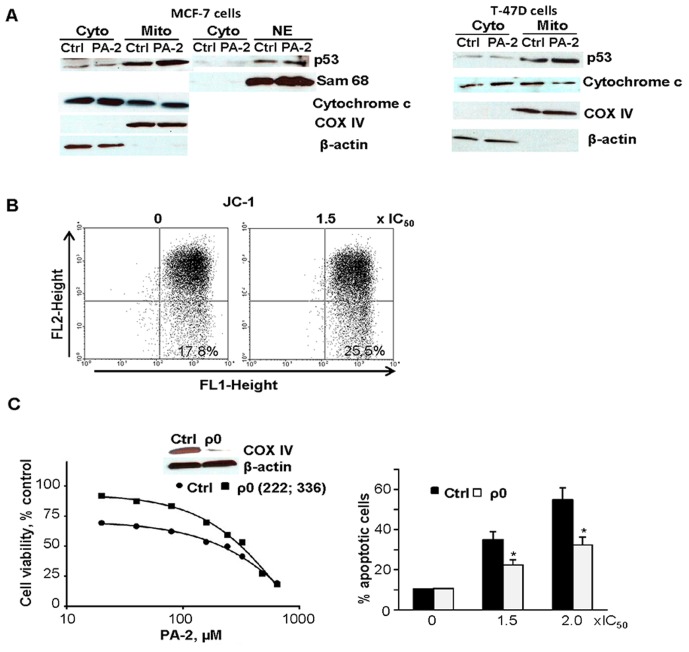
Phospho-aspirin-2 induces mitochondrial translocation of p53 and mitochondria-dependent apoptosis.
A: The mitochondrial, cytosolic and nuclear levels of p53 and cytochrome c were determined after treatment with PA-2 by western blot. B: PA-2 caused the collapse of mitochondrial membrane potential (Δψm), as indicated by the increased JC-1 fluorescence relative to the control. C: Mitochondria-depleted MCF7 cells (ρ0) showed resistance to PA-2. Left: Immunoblotting of control and ρ0 MCF7 cell lysates for the specific marker mitochondrial protein COXIV (top) and the effect of PA-2 on the viability of parental and ρ0 MCF7 cells was determined by the MTT assay (bottom). Right: ρ0 MCF7 cells were resistant to PA-2-induced apoptotic cell death, as measured by Annexin V/PI staining and flow cytometry (results are the average of three independent experiments, *p<0.05).